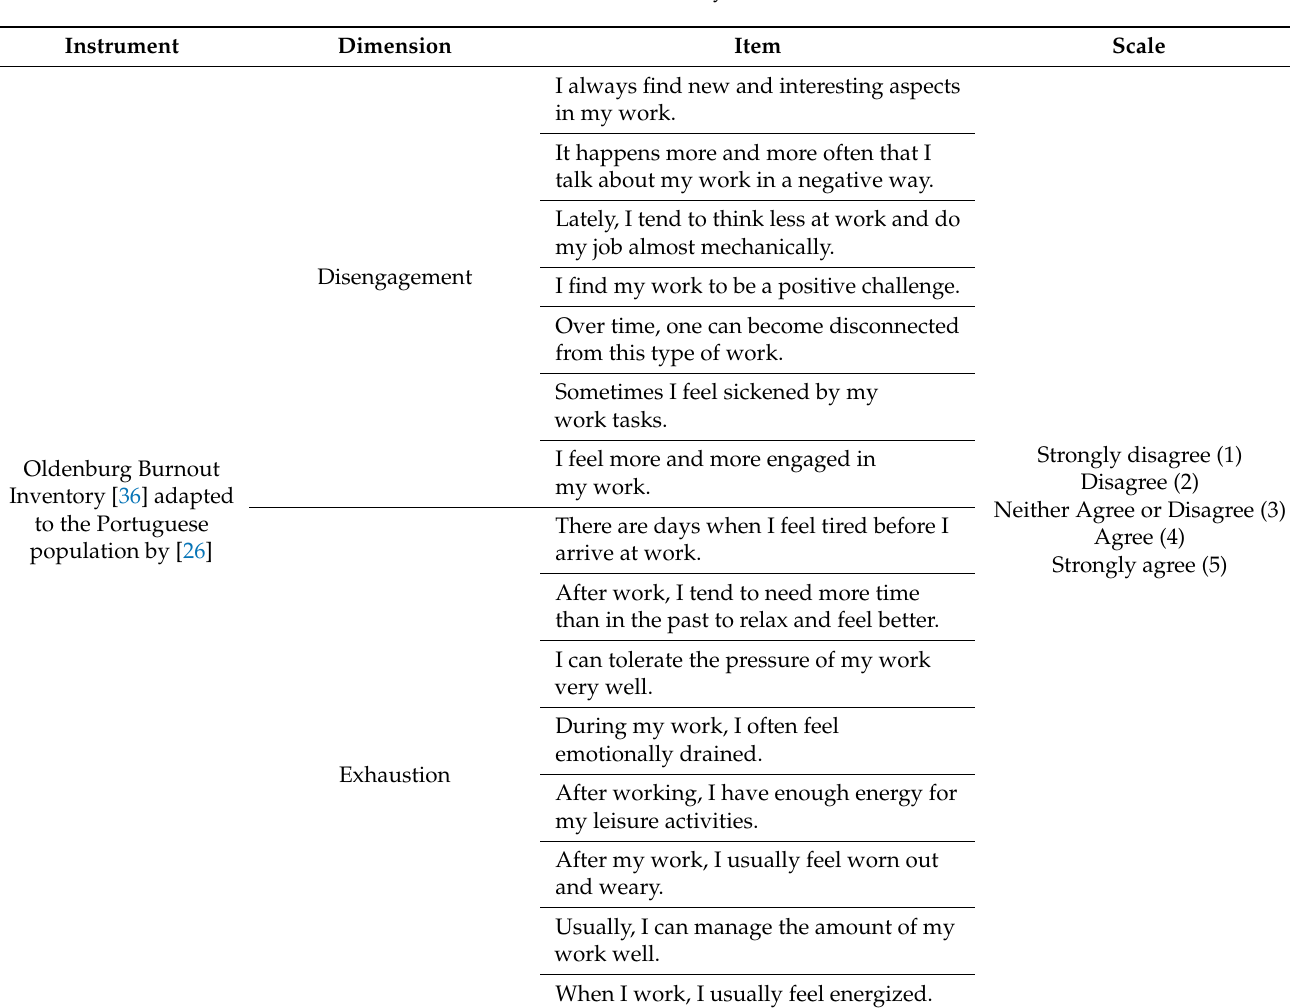
Table A1. Instruments used in this